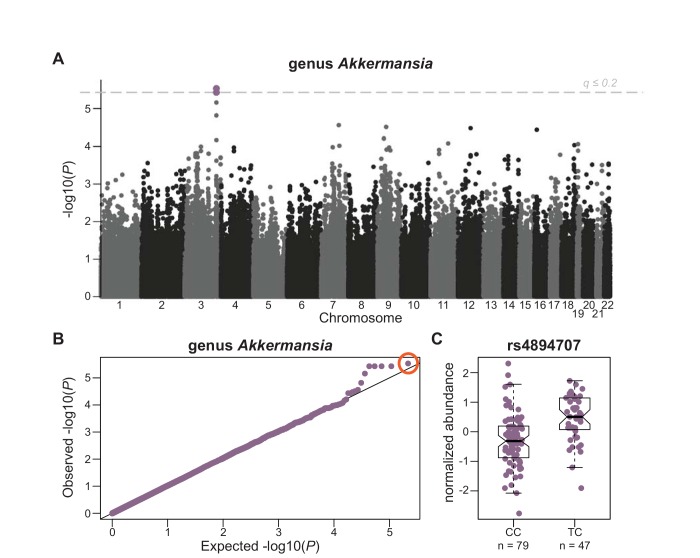
GWAS of genus Akkermansia relative abundance.A) Manhattan plot of GWAS results for the normalized relative abundance of genus Akkermansia from the “seasons combined” analysis. Each point represents a tested SNP, displayed by chromosomal position (x-axis). The y-axis shows–log10(P-value) for each SNP. SNPs significantly associated with normalized Akkermansia relative abundance (q ≤ 0.2) are shown in purple on chromosome 3. B) Q-Q plot for P-values from the GWAS of the relative abundance of genus Akkermansia. The majority of SNPs lie along the null line, demonstrating the test statistics did not appear to be inflated (due to population stratification, for example). Five SNPs (all in linkage disequilibrium (LD) on chromosome 3) were significantly associated with Akkermansia abundance. The point circled in orange was the most highly associated SNP (rs4894707). C) Normalized Akkermansia abundance, segregated by genotype class at rs4894707 on chromosome 3. Only two genotype classes are represented at this SNP (MAF = 0.185 and Hardy-Weinberg P-value = 0.007 in a larger sample of 1,415 Hutterites that includes the individuals in this study). This SNP lies in a UTR region of the gene PLD1, which as been implicated in obesity studies in African American populations[56].